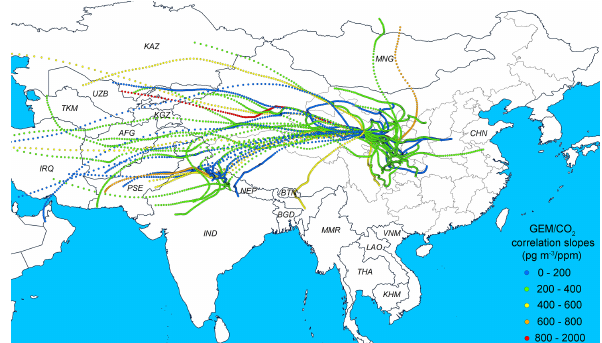
Figure 5. Correlation slopes of GEM/CO 2 at WLG and associated origins of